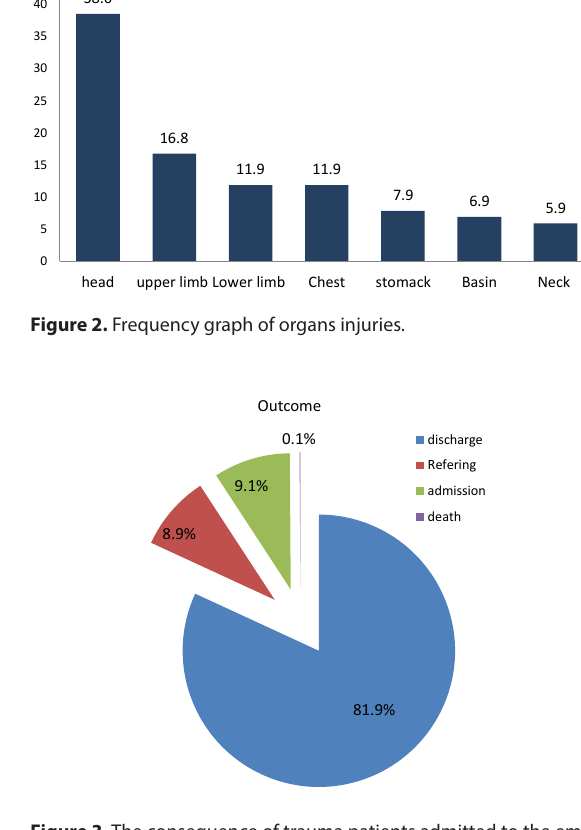
Figure 3. The consequence of trauma patients admitted to the emer- gency department.